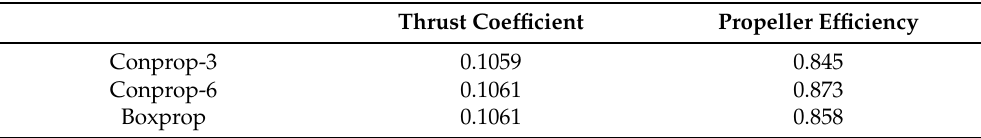
Figure 8. The Pareto Fronts obtained from the optimization of ( a ) Conprop-3, ( b ) Conprop-6 and ( c ) Boxprop. Here the blue stars mark the points where the optimal configurations are extracted. Table 2. The aerodynamic performance of the down-selected optimal propellers, obtained from the preliminary prediction using RANS in the